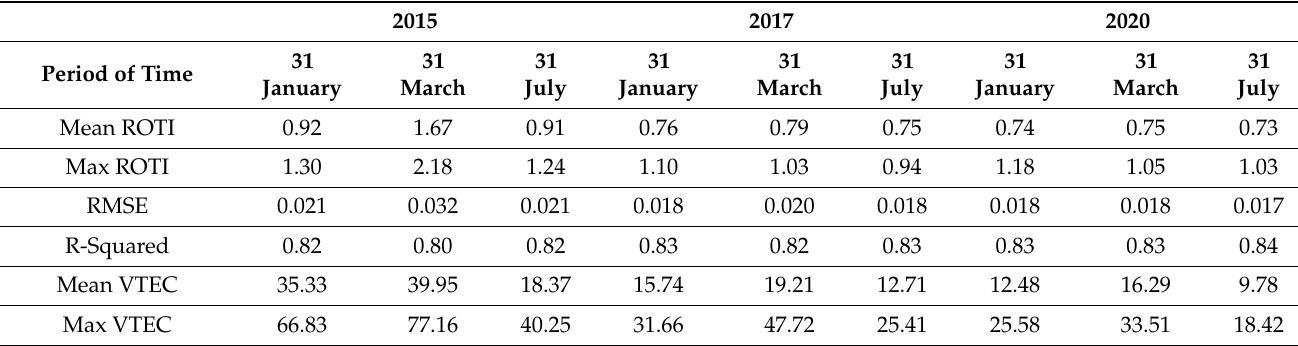
Table 4. The difference between predicted and observed ROTI and observed VTEC values during 24 h on 31